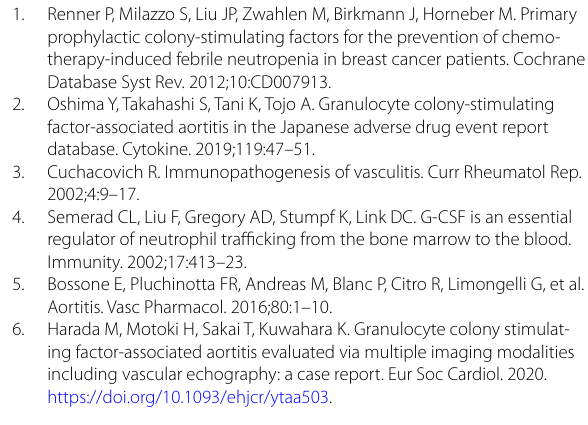
PEG-G: pegfilgrastim a Days with fever from G-CSF